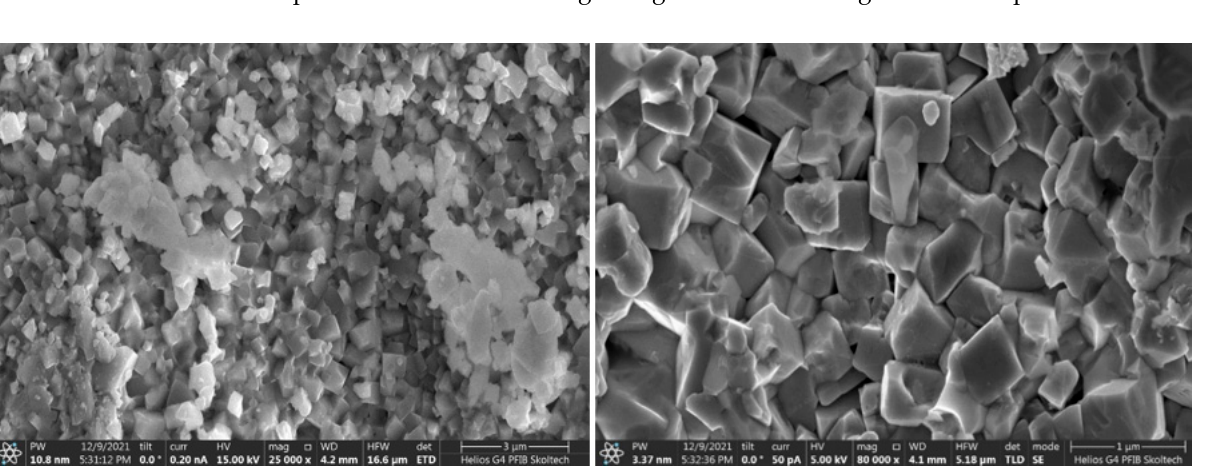
tion are formed during a longer time of the sol-gel formation process.